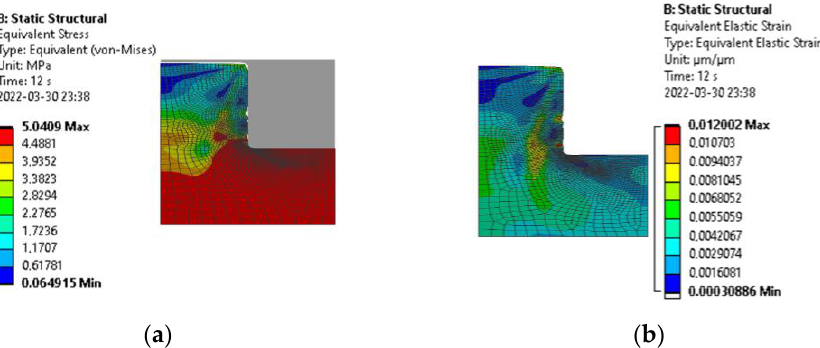
Figure 7. Stress and strain distribution: ( a ) Equivalent stress legend and stresses at maximum strain; ( b ) residual stress image with the equivalent elastic strain legend.